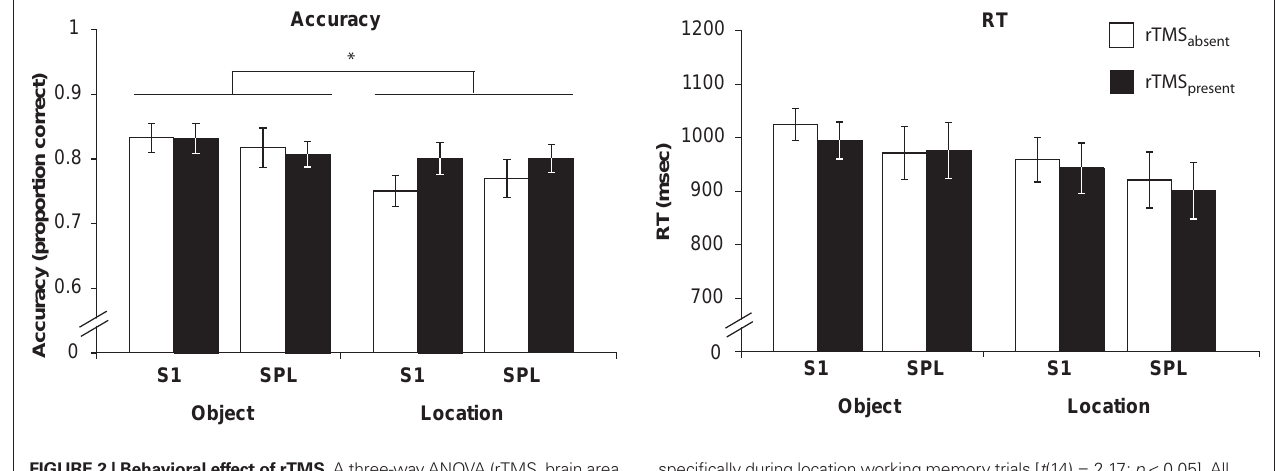
FIGURE 2 | Behavioral effect of rTMS. A three-way ANOVA (rTMS, brain area, memory task) on accuracy from revealed a main effect of memory task [ F (1,14) = 5.22; p < 0.05] and a signifi cant rTMS × memory task interaction [ F (1,14) = 4.72; p < 0.05, marked with an asterisk]. The main effect of